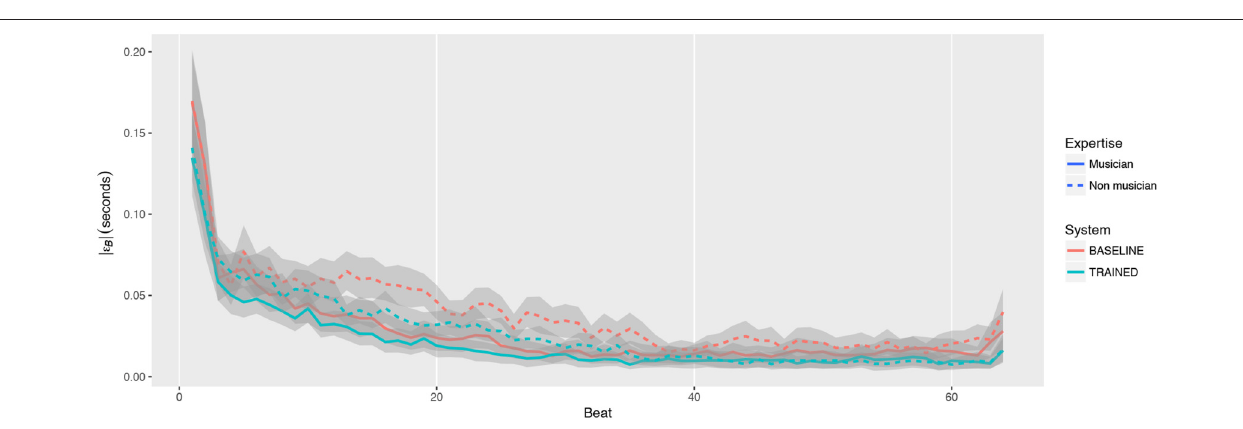
FIGURE 13 | Average evolution of absolute beat error ( | ε B | ) for different combinations of SYSTEM and EXPERTISE